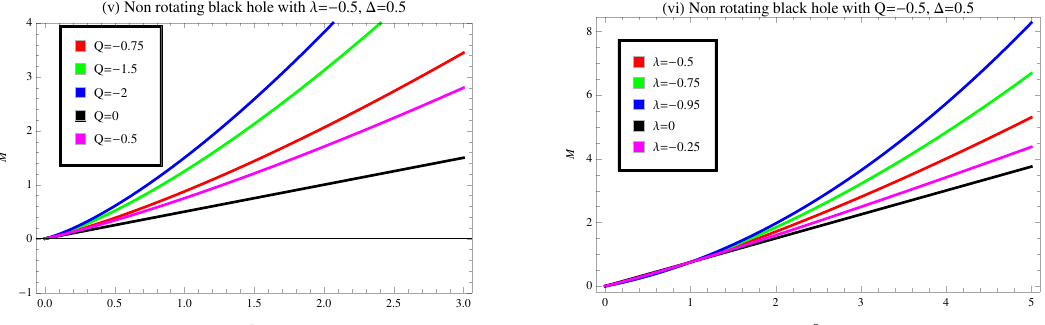
Figure 1. Plot of mass M versus horizon radius r + for non-rotating BH for various choices of λ , ∆ and Q